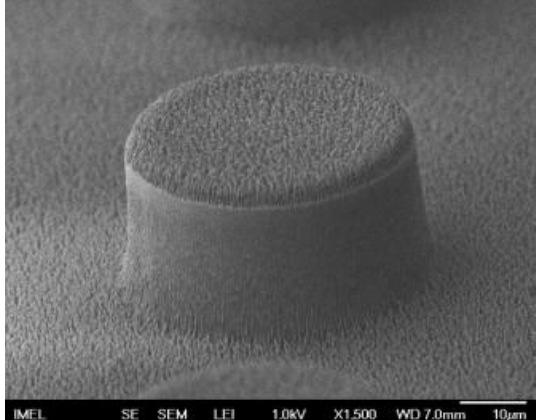
Figure 7. Dual-scale topography of O 2 plasma-treated micro-structured SU-8 surfaces (SEM image). Reproduced with permission from [42]. Copyright 2009 Elsevier B.V.